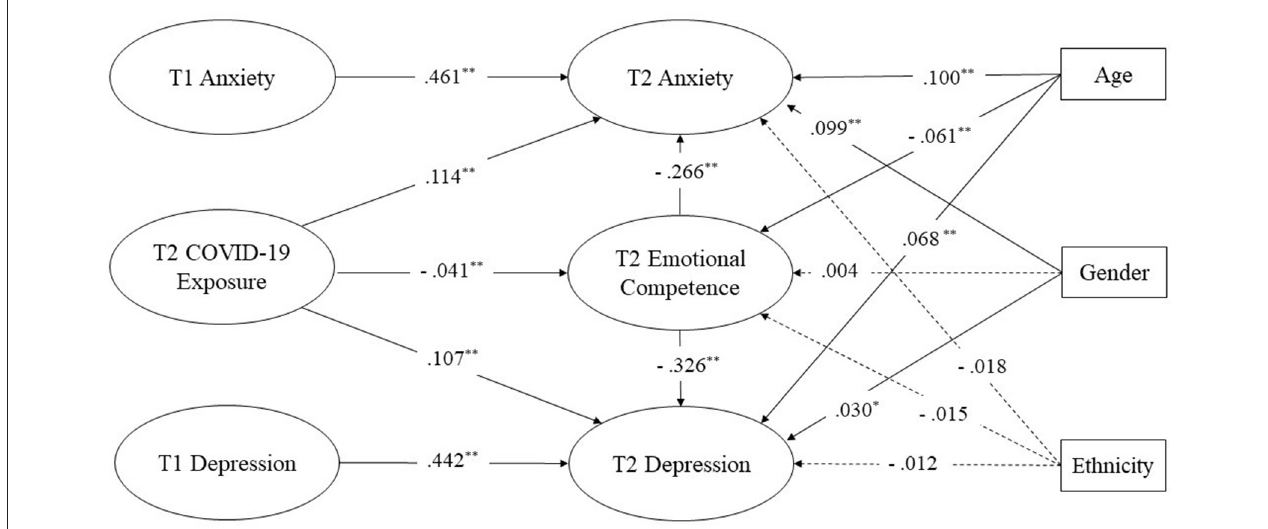
FIGURE 1 | Longitudinal mediation model with standardized path coefficients. * p < 0.05, ** p < 0.001; For simplicity, factor loadings of all items are not displayed in this figure. Dotted lines displayed the non-significant paths; Solid lines displayed the significant paths.